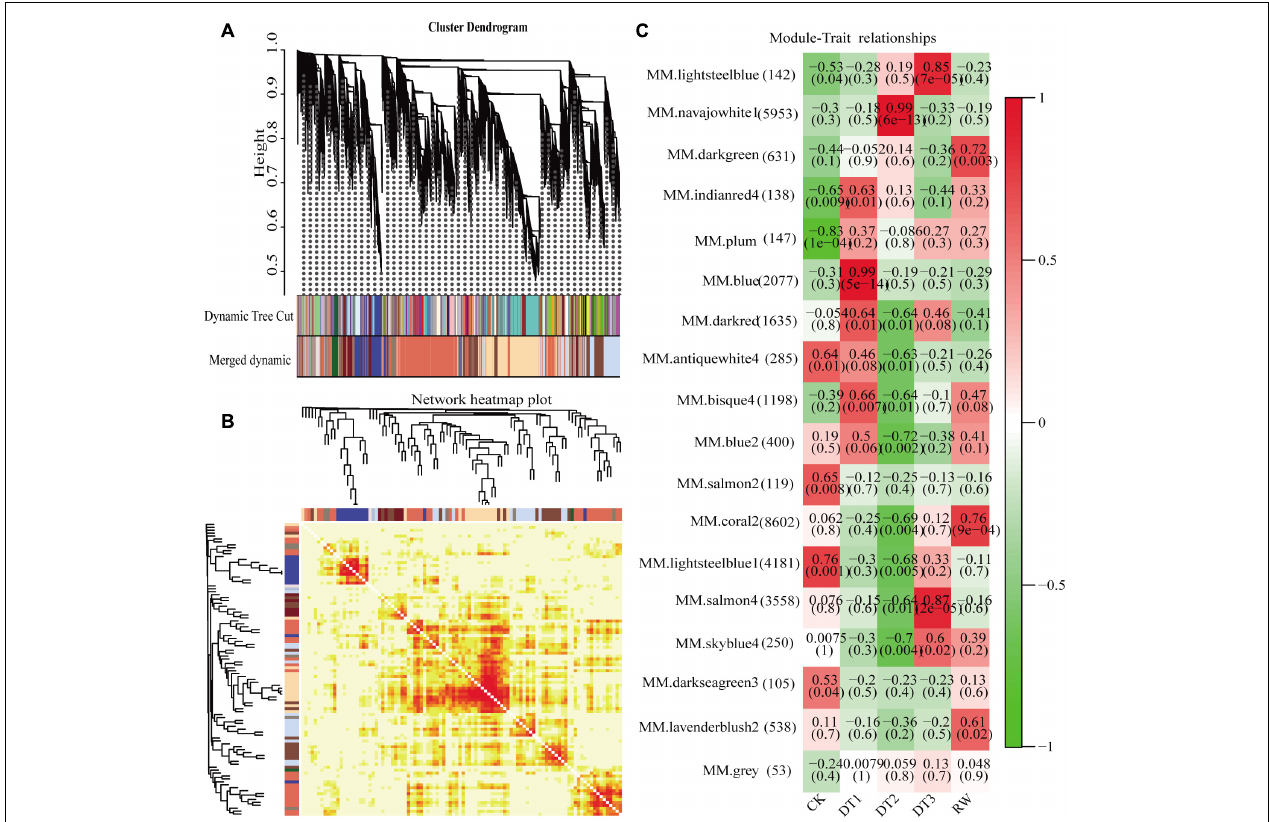
FIGURE 5 | Identification of DEGs by WGCNA. (A) Module level clustering diagram. (B) Network heatmap plot. (C) Module-trait associations. (Each column corresponds to different processing conditions, and each row corresponds to the characteristic gene of the module. The correlation between two is indicated in cell by Pearson correlation coefficient and p value in parentheses. Cell color ranges from red (high positive correlation) to green (high negative correlation), and the number of genes contained in each module is in left parentheses).